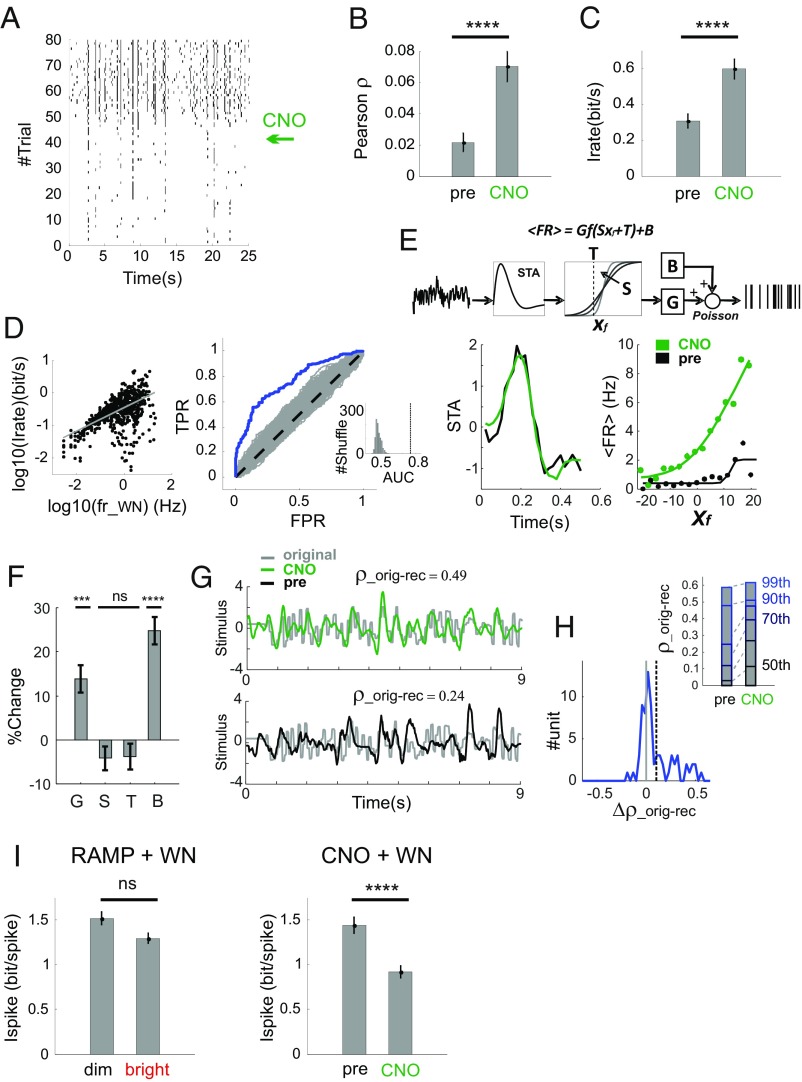
Impact of ipRGC-driven increases in firing on neural coding. (A) As in Fig. 5A for a representative CNO-responsive unit from an hM3Dq-expressing retina; arrow to Right shows time of CNO administration. (B and C) Trial-to-trial reproducibility (B) and information rate (C) for the block of 40 trials after (“CNO”) than before (“pre”) CNO delivery in units expressing increase in firing rates post-CNO (P = 0.00014, P ∼ 0 for G and B, P = 0.433 and 0.229 for S and T; n = 393; sign test). (D–H) As in Fig. 5 D–H, but applied to CNO+WN experiments in hM3Dq retinas; accordingly, distribution of Δρorig-red in H is for neurons exhibiting CNO-related increases in firing. (I) Coding efficiency, calculated as bits per spike, was equivalent in “dim” vs. “bright” portions of the irradiance ramp (Left) but significantly reduced following CNO delivery (Right). ***P < 0.001, ****P < 0.0001 for rank sum test.